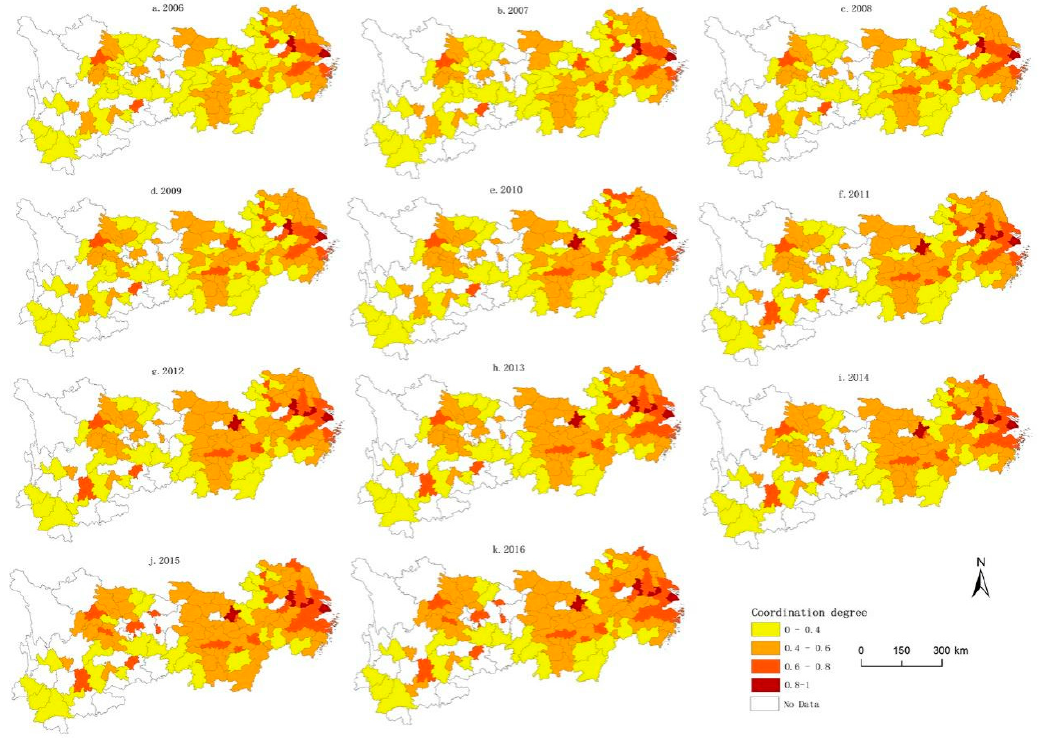
Figure 4. Spatial distribution of PLIU coordination degree in the YREB from 2006 to 2016. The high coordination and the high coupling area are roughly consistent, being mainly distributed in developed cities, a provincial capital city, and the central city of the downstream area. Moderate coordination and low-grade coordination are mainly distributed in cities in the middle and upper reaches. Non-harmonious cities are mainly distributed in the provinces of Yunnan and Guizhou. In general, the coordination is characterized by the distribution of stripes, which are gradually decreasing from east to west. The coordination degree of the upper reaches is the lowest, but the base is small, the potential for ascension is great, and the growth rate is faster. The coordination degree of the middle reaches is moderate, and the growth is slower. The coordination degree of the down- stream cities is the highest, the base is large and the growth is slow. The coordination of the YREB has been rising, and the difference is narrowing. Urbanization is also becoming more coordinated and balanced. 3.3. The Spatial Correlation Characteristics of PLIU Coordinated Development In order to reveal the spatial correlation characteristics of PLIU coordinated develop- ment in YREB, GeoDA is employed to conduct global spatial autocorrelation and local spatial autocorrelation analysis based on the coordinated development evaluation results from 2006 to 2016. 3.3.1. Global Autocorrelation Analysis The global Moran’s I index was adopted to analyze the spatial correlation level of coordinated development, and the spatial weight matrix was constructed in the GeoDA platform. Based on the coordinated development degree of 110 cities in the YREB in 11 years, the correlation level of coordinated development was calculated (Figure 5). In the Figure 5, CD2006, CD2010, and CD2016 represent the autocorrelation level of coordina- tion degree in 2006, 2010 and 2016, respectively.